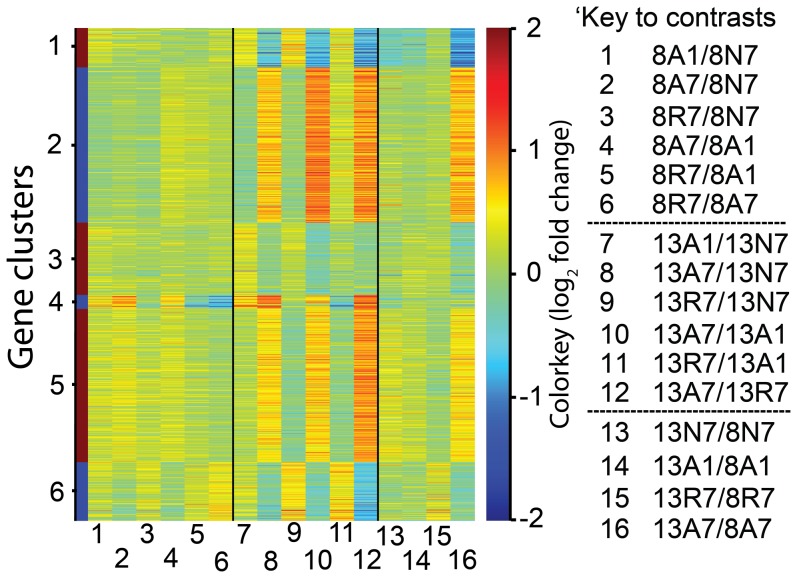
Heat map representing the log2 fold-change values between contrasted treatments for the 844 genes found to be differentially expressed in at least one of the contrasts.Each of the 16 columns represents a different contrast between treatment groups, as indicated in the key to the right, and as illustrated in Figure 1; note that the 13A7 group was the denominator in most of these contrasts. The value of fold-change between contrasted treatments for each gene was indicated by the coloured scale, with red indicating a value>1 and blue indicating a value <1. Genes were clustered into 1-6 groups using the K-means technique, each possessing broadly the same profile across all contrasts.